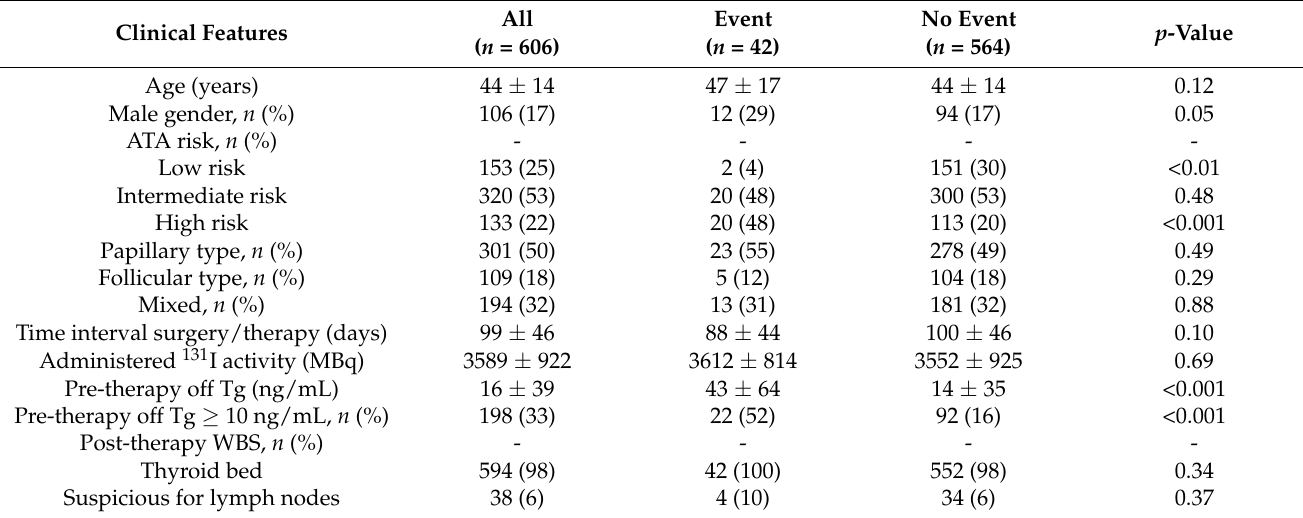
Table 1. Characteristics of the study population at the time of RAI therapy according to events.